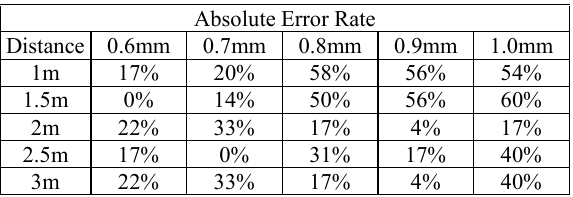
Table 7. The absolute error rates. Line charts of the average error rate with standard deviation are presented in Figure 12. The average error for the measurement of error rate gets higher as the shooting distance increases.